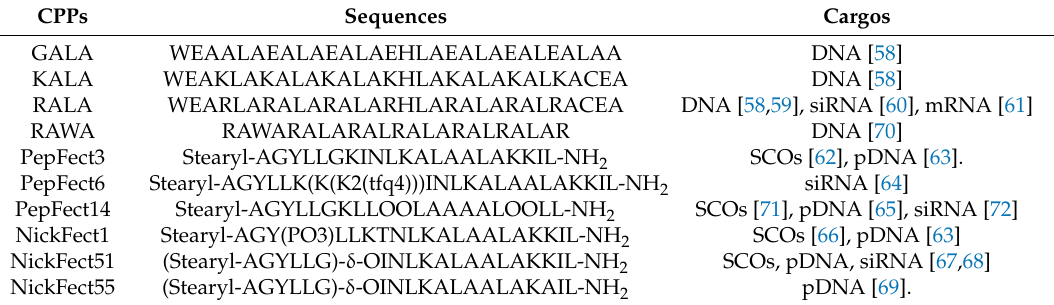
Table 3. Sequence of cell-penetrating peptides (CPPs) for nucleic acid